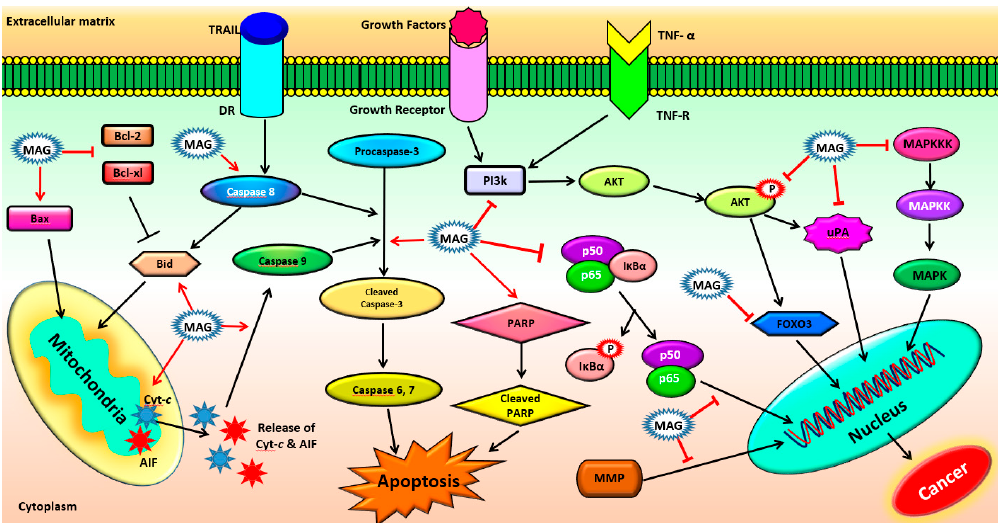
Figure 3. Effect of magnolol on different molecular signaling pathways. (MAG: Magnolol; Τ : Inhibition/Downregulation; ↑ : Activation/Upregulation; Τ : Inhibition/Downregulation by MAG; ↑ : Activation/Upregulation by MAG).